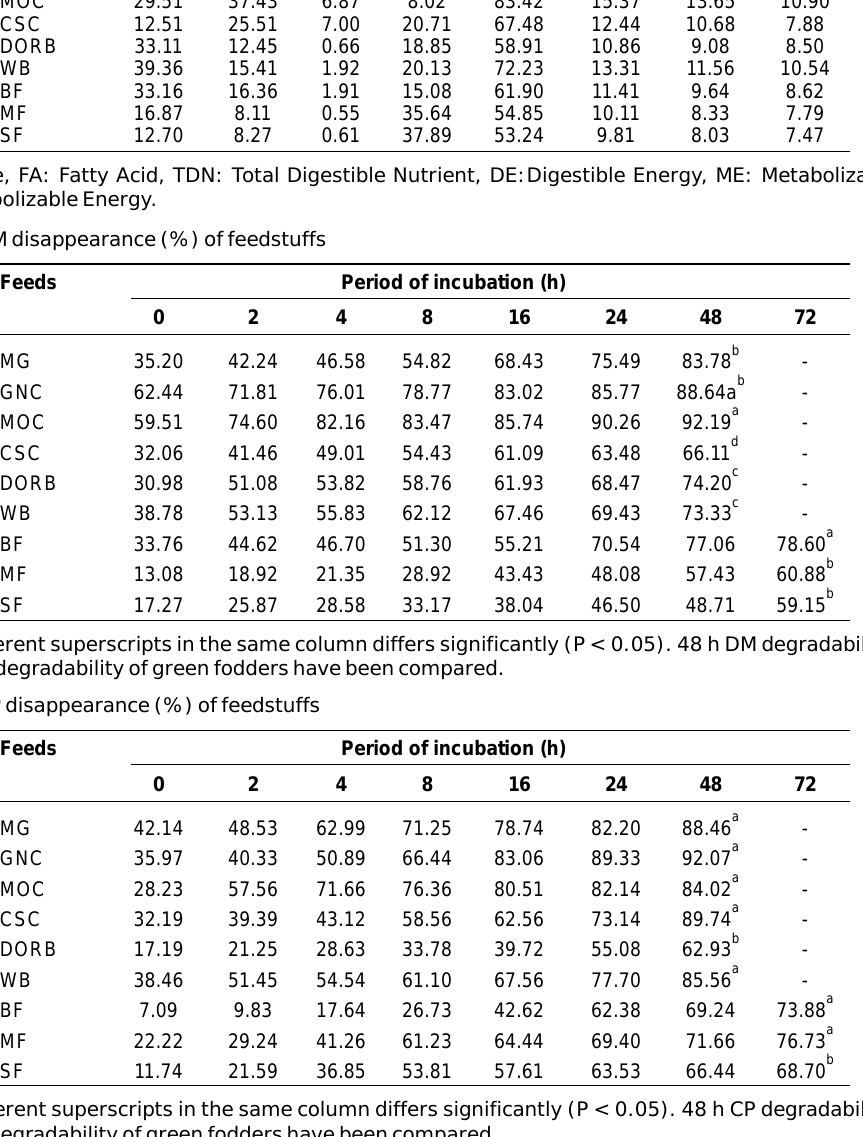
Table-2. MG, GNC and MOC contained higher TDN and ME values among concentrate feeds, while among